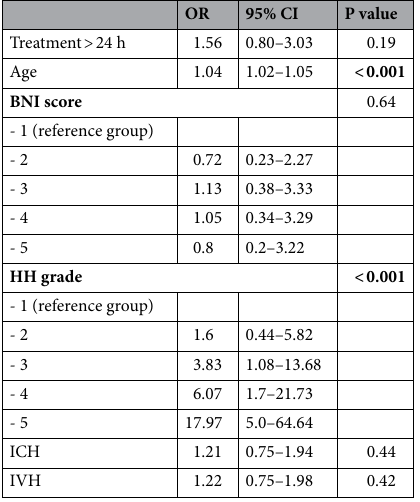
Table 5. Multivariable analysis in-hospital mortality. BNI Barrow Neurological Institute, HH Hunt and Hess, ICH intracerebral haemorrhage, IVH intraventricular haemorrhage. Significant values are in